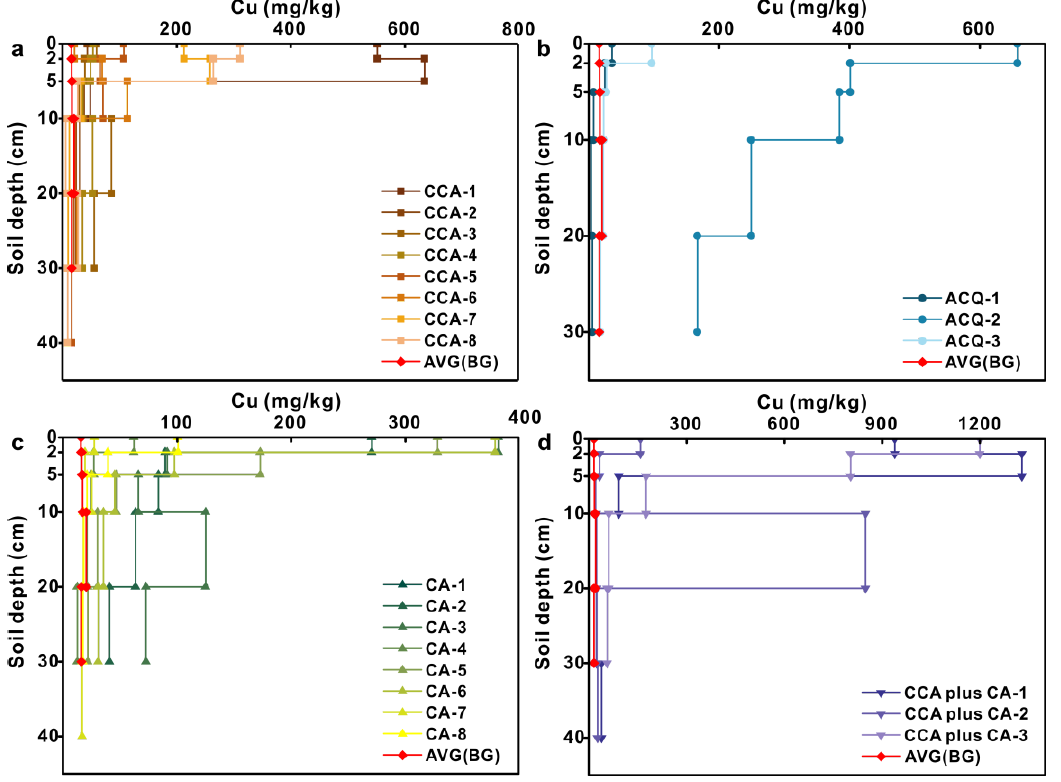
Figure 6. Vertical distribution of Cu concentration in soil samples under wooden walkway with four treatments: ( a ) CCA treatment; ( b ) ACQ treatment; ( c ) CA treatment; ( d ) CCA plus CA treatment.